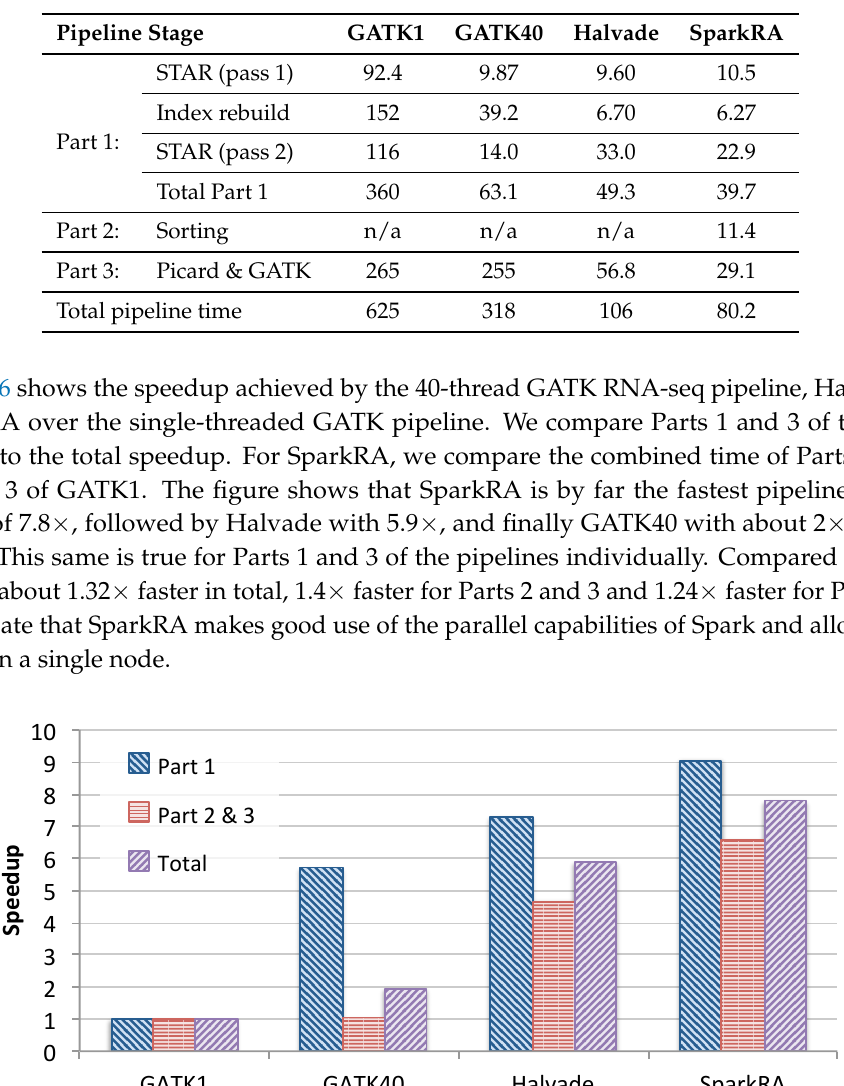
Table 2. Pipeline computation time (in minutes) comparison of GATK RNA-seq running with one thread (GATK1) and 40 threads (GATK40) with Halvade-RNA and SparkRA (single-node performance).